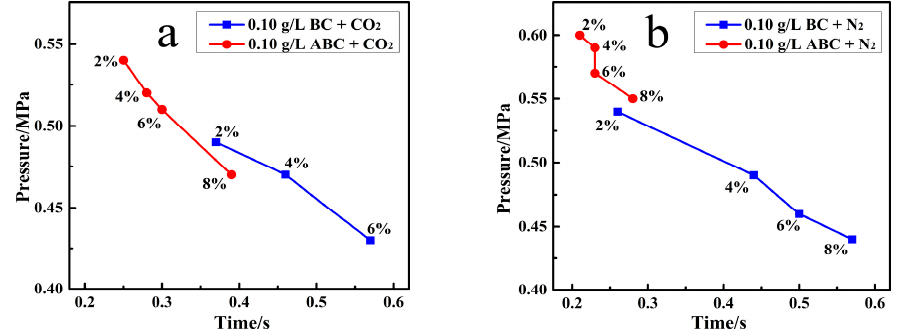
Figure 3. The explosion characteristic parameters of methane inhibited by different powders with inert gas: ( a ) different powders/CO 2 ; ( b ) different powders/N 2 .